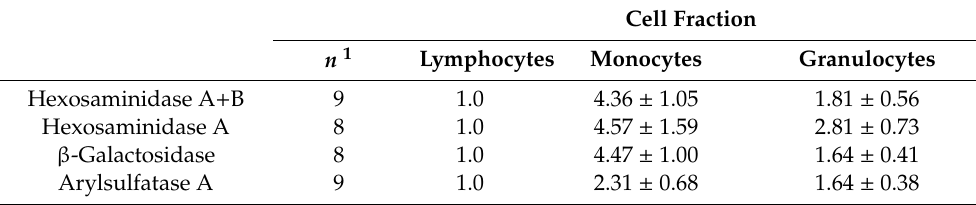
Comparison of arylsulfatase A, β -hexosaminidase A, β -hexosaminidase A + B and β -galactosidase activities in the di ff erent leukocyte fractions normalized to lymphocyte fraction set as